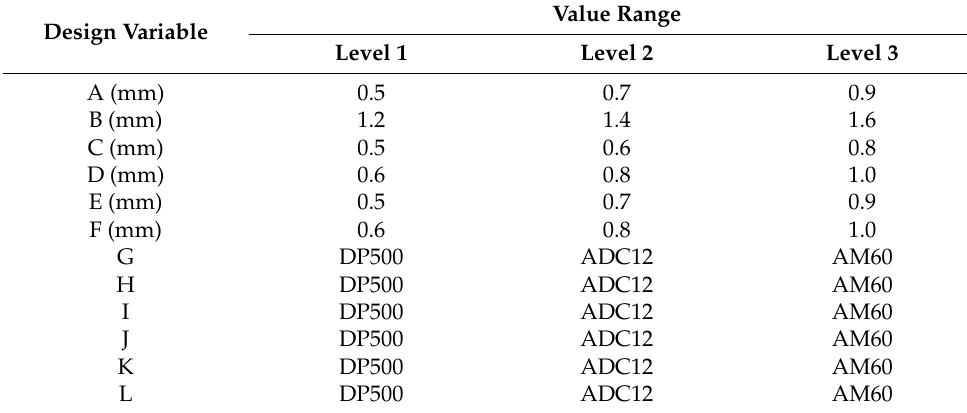
Table 4. Discrete design variables and corresponding